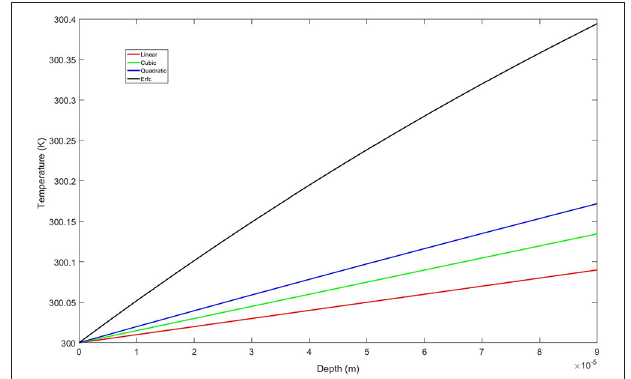
FIGURE 6 | Structure of thermal boundary layers for fixed surface temperature over the optical depths of both the mid- and long-wave thermal bands.